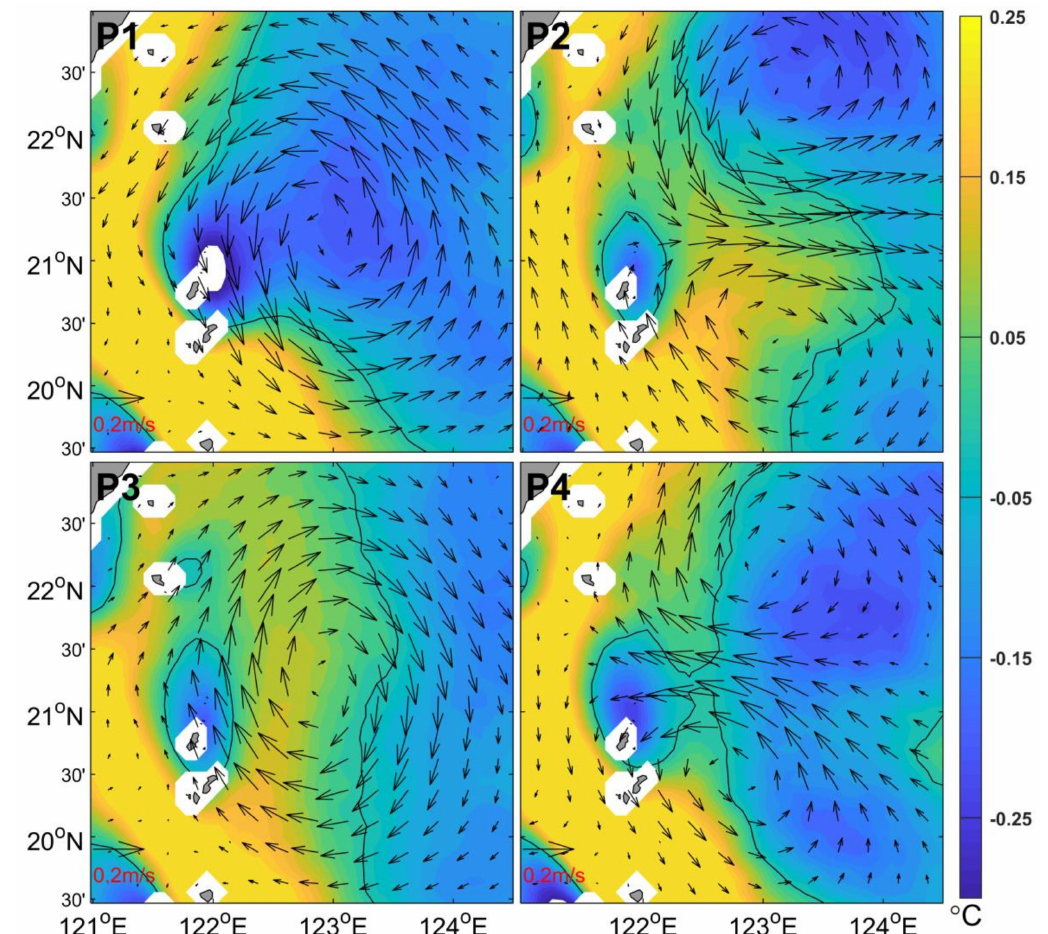
Figure 7. The spatial pattern of high-pass-filtered RSS SST corresponding to 2 × 2 SOM patterns derived from the AVISO ADT fields for the east branch. Geostrophic current anomaly (m/s, in vector); SST ( ◦ C, in color). The spatial filtering is done by subtracting a 4 ◦ moving average from the original RSS SST data to remove the large-scale background state. The black line represents a zero contour